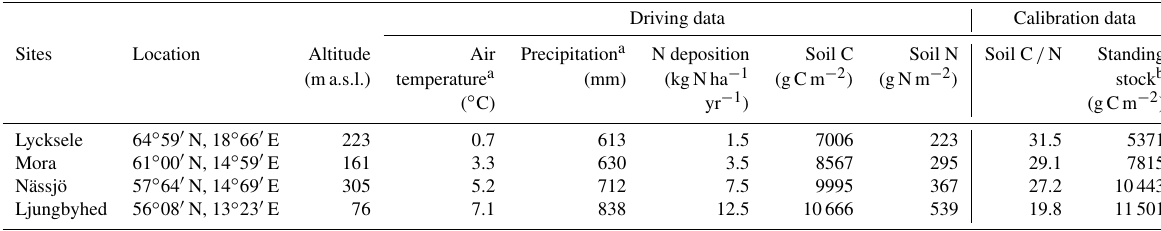
Driving data Calibration data